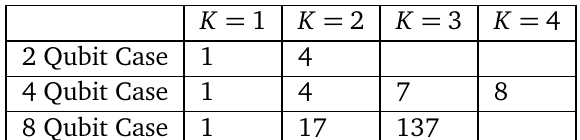
Table 1: Comparison of the number of basis states used to construct the hybrid ansatz for each K for each Hamiltonian. For example, the K = 2 expansion for the 4 qubit case, using the Hamiltonian H , requires 4 quantum states to construct the 4 hybrid ansatz. We only considered unique states, which correspond to only taking unique Pauli strings. For example, in the 8 qubit case, while the number of Pauli strings in the Hamiltonian is 15, which might suggest the K = 3 expansion generates 15 3 + 15 2 + 15 + 1 = 3616 Pauli strings and thus 3616 states, many of them are repeated and only 137 of those strings are unique. Thus, we only end up having 137 states in our ansatz which turns out to be sufficient to represent the full dynamics of the 2 8 = 256 dimensional Hilbertspace. This could be due to the transverse Ising model having underlying symmetries that reduce the number of basis states needed to capture the full dynamics. K = 1 K = 2 K = 3 K = 4 2 Qubit